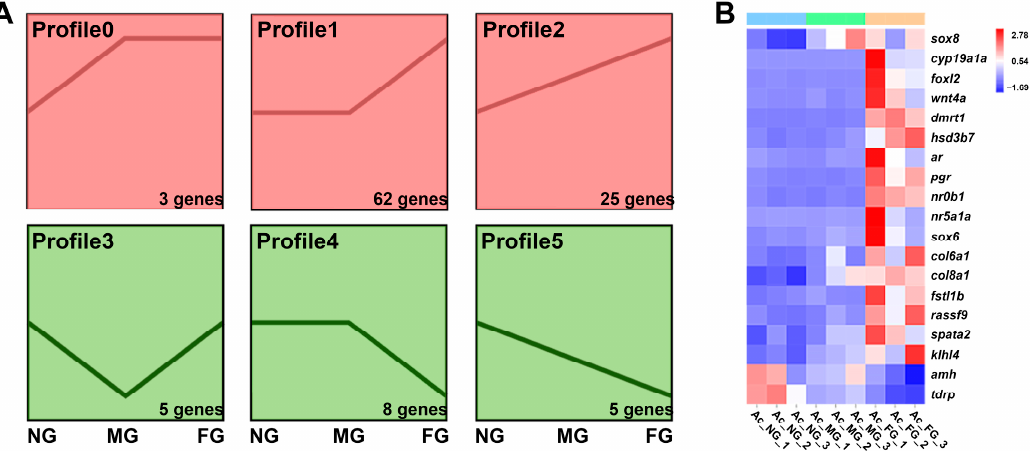
Figure 5. Expression profile analysis of sex-related genes in A. clarkii . ( A ) Six expression profiles and the number of sex-related genes in each profile by K-means analysis. ( B ) Heatmap showing the relative expression levels (Z scores) of sex-related genes in NG, MG, and FG.